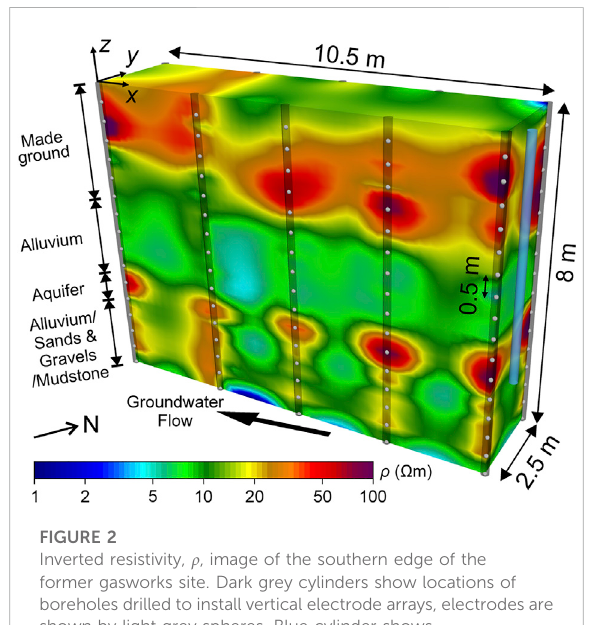
FIGURE 2 Inverted resistivity, ρ , image of the southern edge of the former gasworks site. Dark grey cylinders show locations of boreholes drilled to install vertical electrode arrays, electrodes are shown by light grey spheres. Blue cylinder shows groundwater monitoring well used to inject saline tracer into the